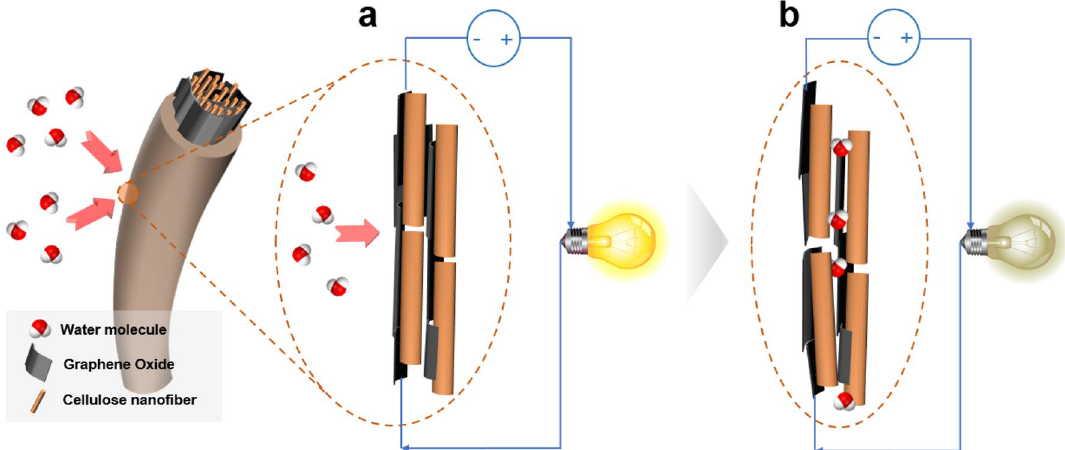
Figure 11. Illustration of the electrical resistance change in the CNGO hybrid filament under humidity change: ( a ) dry condition and ( b ) humidity